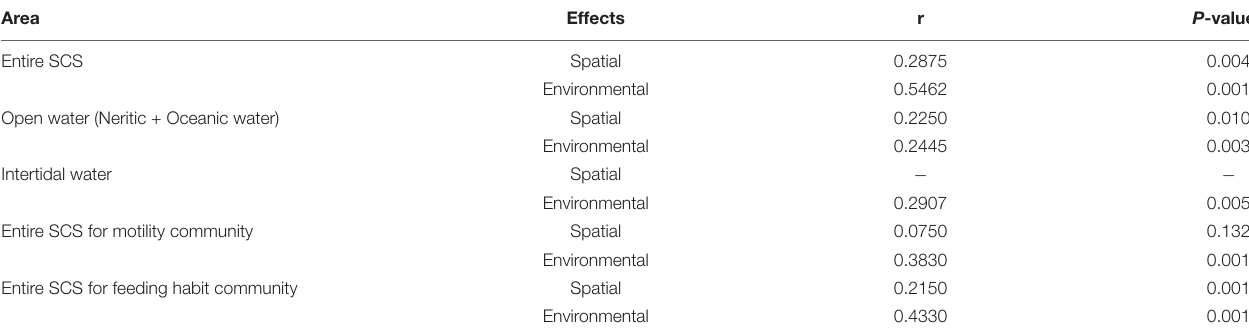
TABLE 3 | Mantel tests for the correlation between community and spatial, environmental variables using Pearson’s